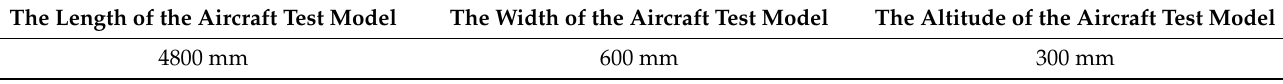
Table 3. Limit size of aircraft test models allowed by BSD.